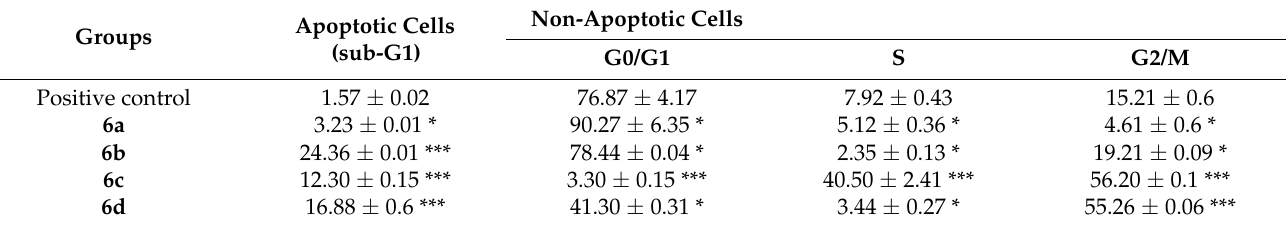
Table 10. Flow cytometric analysis of cell cycle distribution of EAC cells.